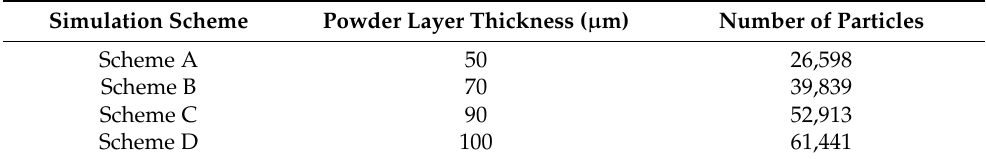
Table 2. Simulation schemes to study the effect of powder layer thickness on the SLM spatter behavior.